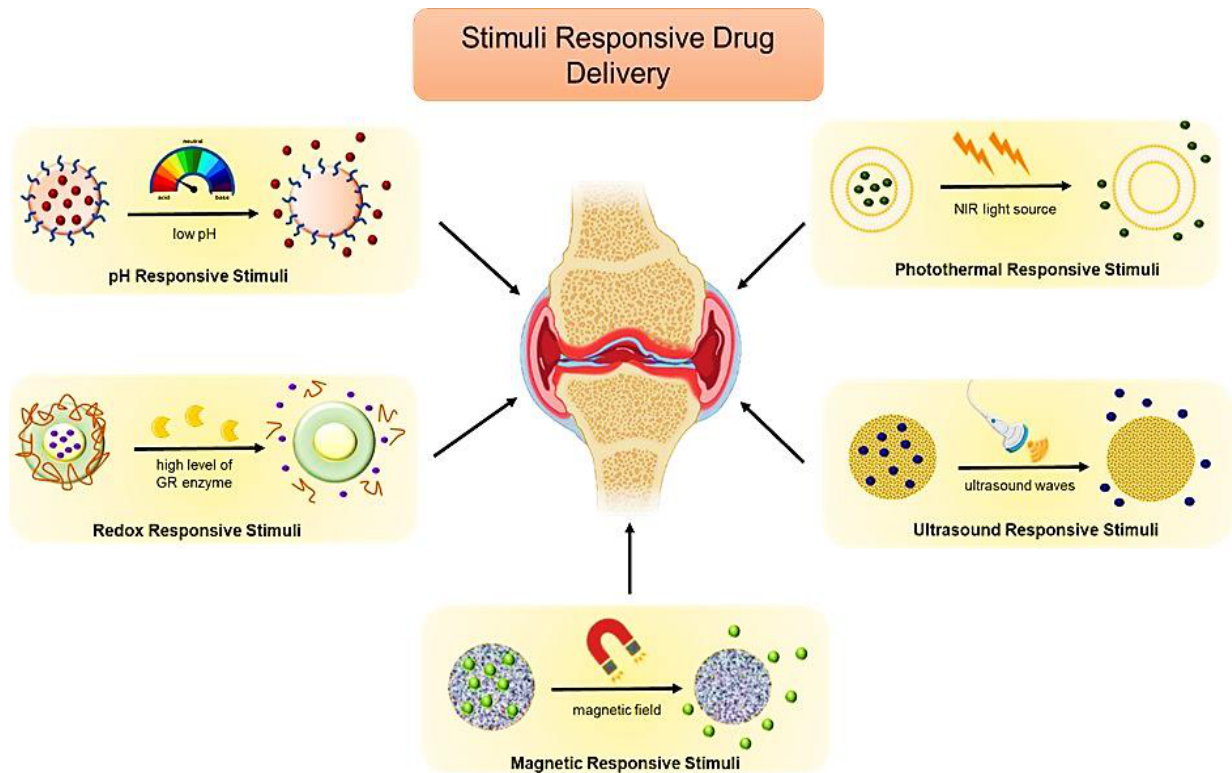
Figure 10. Stimuli-responsive biomimetic nanomedicines.